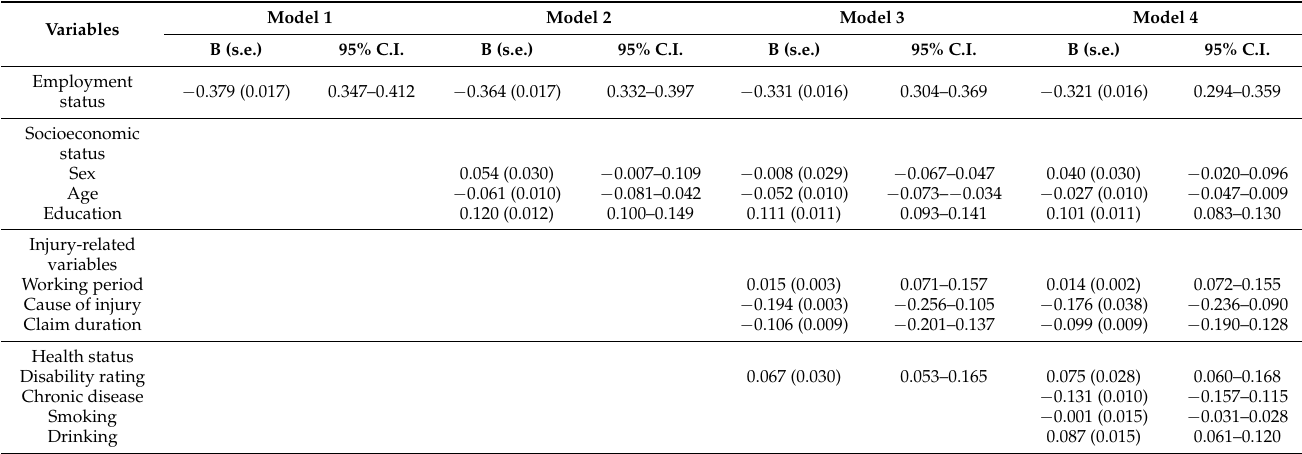
Table 3. A longitudinal association analysis between precarious employment and overall health